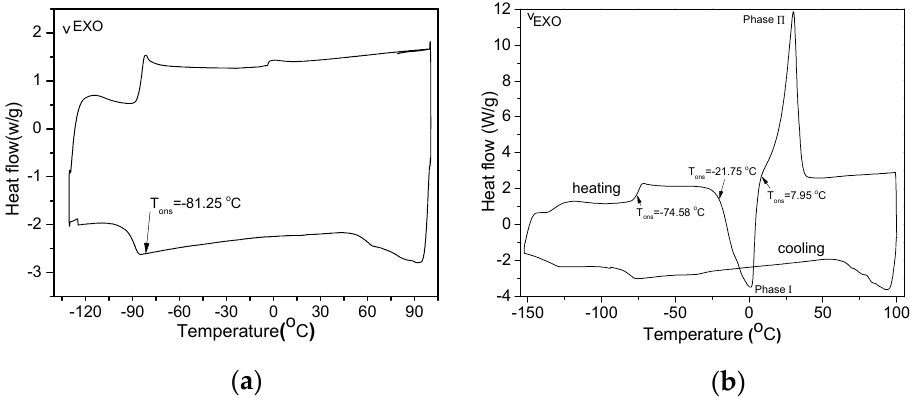
Figure 5. Typical DSC curves of ME-FILs. ( a ) ME-FIL 2 ; ( b ) ME-FIL 7 . v EXO represents the exothermic direction; T ons represents the onset of heat capacity change for T g , or the onset of an endothermic change for T m, or the onset of an exothermic change for T cc .